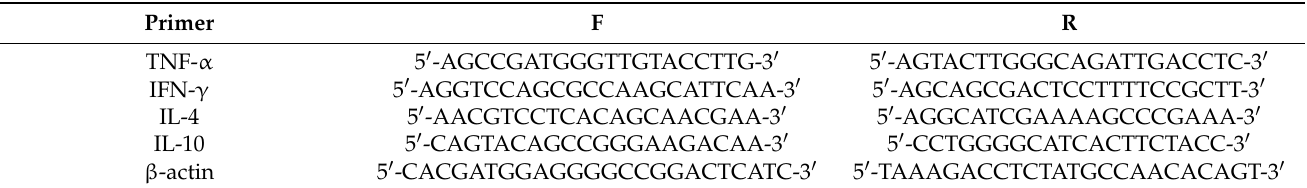
Table 1. Primer sequences for